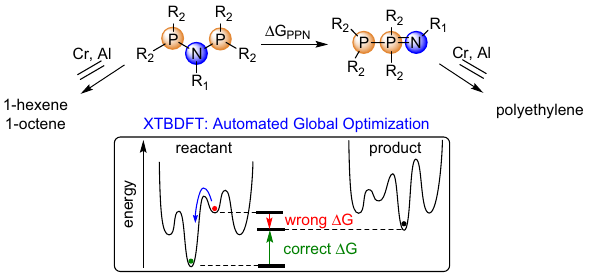
Figure 2. Diphosphinoamine (PNP) to iminobisphosphine (PPN) isomerization and illustrative potential energy